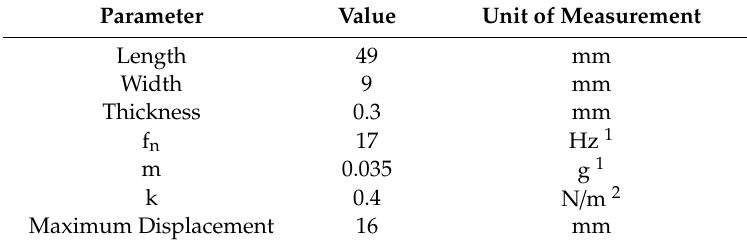
Figure 4. Picture of the BC-based device used as a green energy harvester. Table 1. Characteristics of the BC transducer used as a green energy